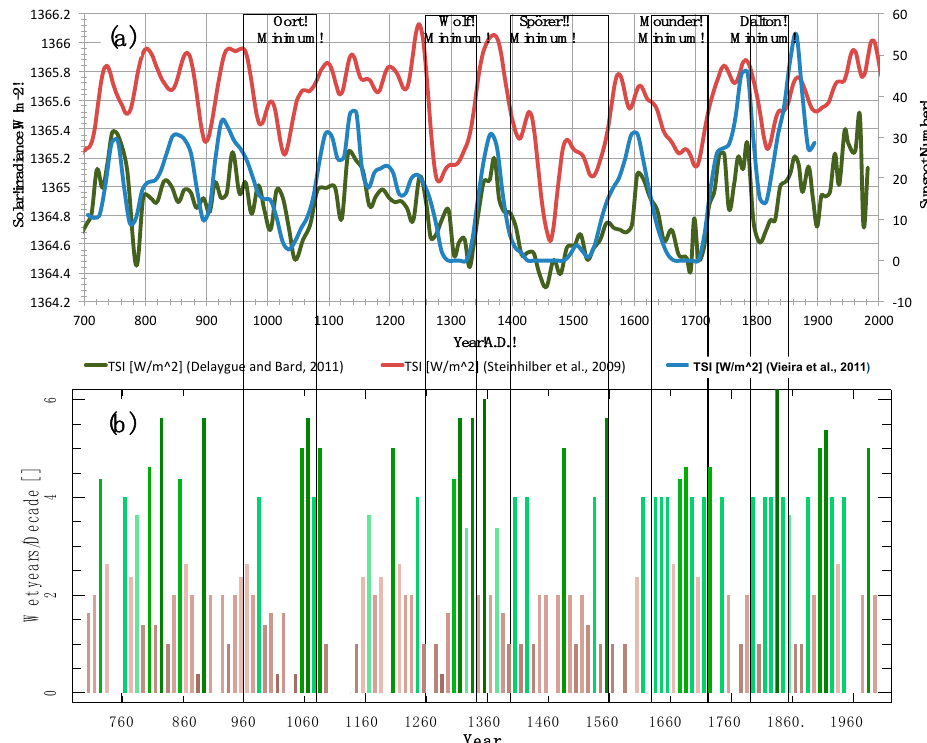
Figure A2. A full last millennium segment of the ( a ) solar irradiance curve and ( b ) wet years per decade record in the El Niño impacted region in southwest US and Northern Mexico (see Figure 5c).